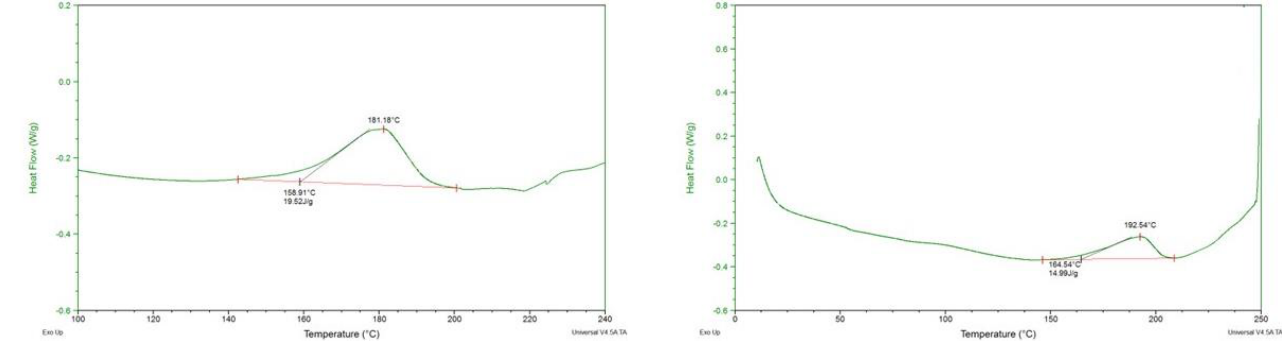
Figure 5. DSC thermograms showing start and peak temperature for protein denaturation and enthalpy for denaturation for two representative ingredients—PP1 ( left ) and soy mix ( right ).